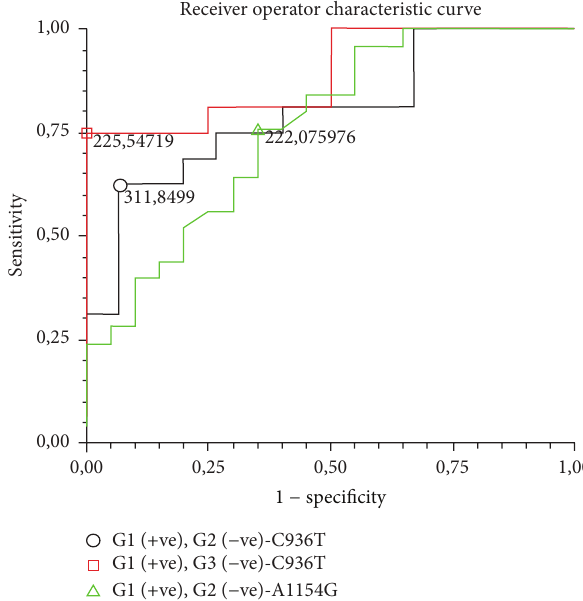
Figure 3: Receiver operator characteristic curve (ROC) of serum vascular endothelial growth factor (VEGF) levels in patients with ( I ) mutant allele of VEGF -C936T in the group with hepatocellular carcinoma (G1) and cirrhosis (G2) (area under the curve = 0.80 [0.60 – 1.0] ), with sensitivity of 63% and specificity of 93%, to the cut-off value of 311.8pg/mL; ( ◻ ) mutant allele of VEGF -C936T in G1 and controls (G3) (area under the curve = 0.89 [0.60 – 1.0] ), with sensitivity of 75% and specificity of 100%, to the cut-off value of 225.5 pg/mL; ( 󳵻 ) mutant allele of VEGF -A1154G in G1 and G2 (area under the curve = 0.76 [0.60 – 0.92] ), with sensitivity of 76% and specificity of 65%, to the cut-off value of 222.1